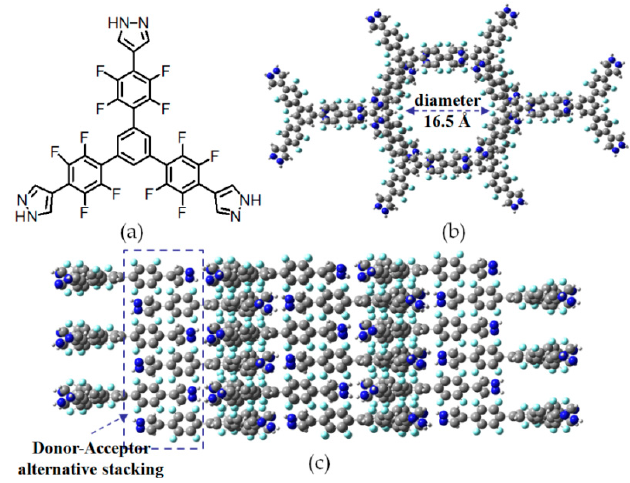
Figure 8. ( a ) Structure of building motif 7 ; ( b , c ) Hexagonal channels and alternative crystal stacking of H7 .